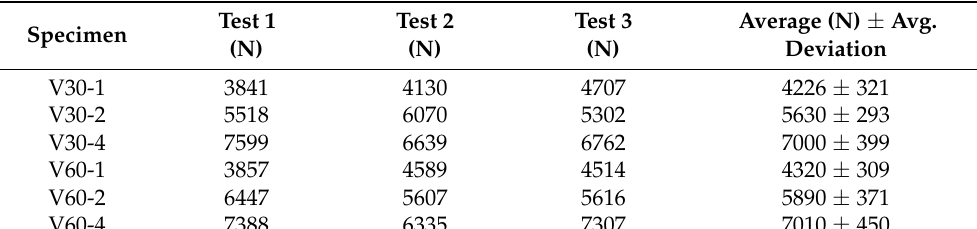
Table 3. LBC (maximum load) values obtained in the fracture tests of AA7075-Cu weld material.